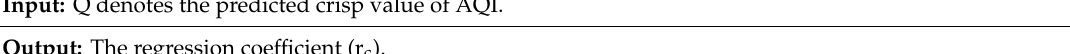
Algorithm 4: an algorithm to calculate regression coe ffi cient based on predicted AQI crisp